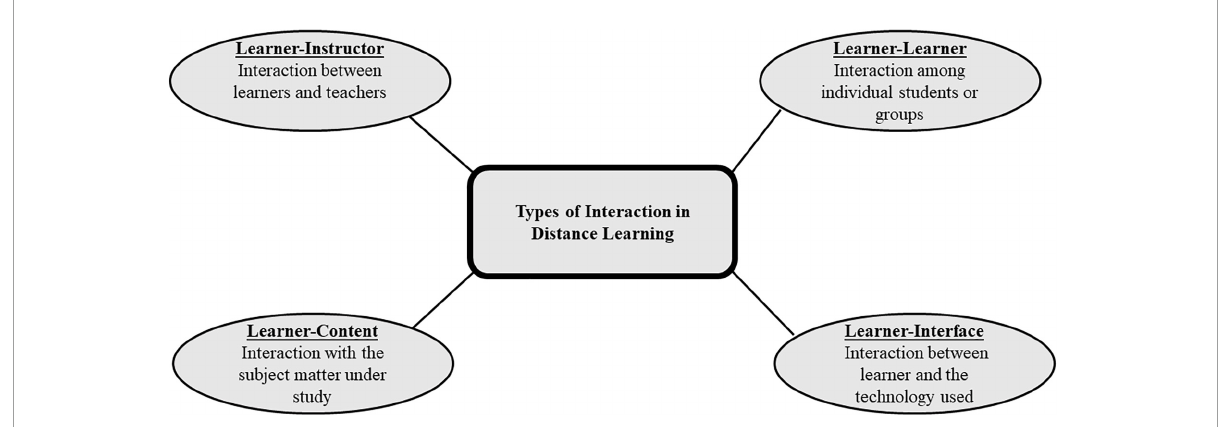
FIGURE1 The four types of interactions that occur in distance learning. Moore’s theory of transactional distance was adopted as a framework in our qualitative